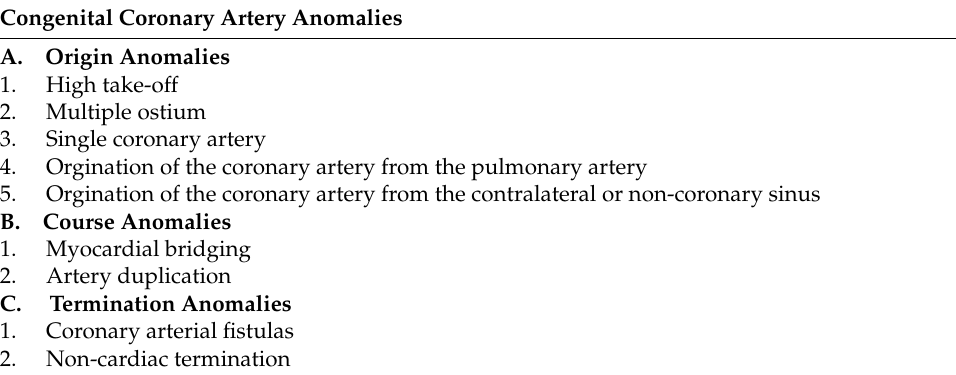
Table 1. Classification of congenital coronary artery anomalies by Greenberg et al.